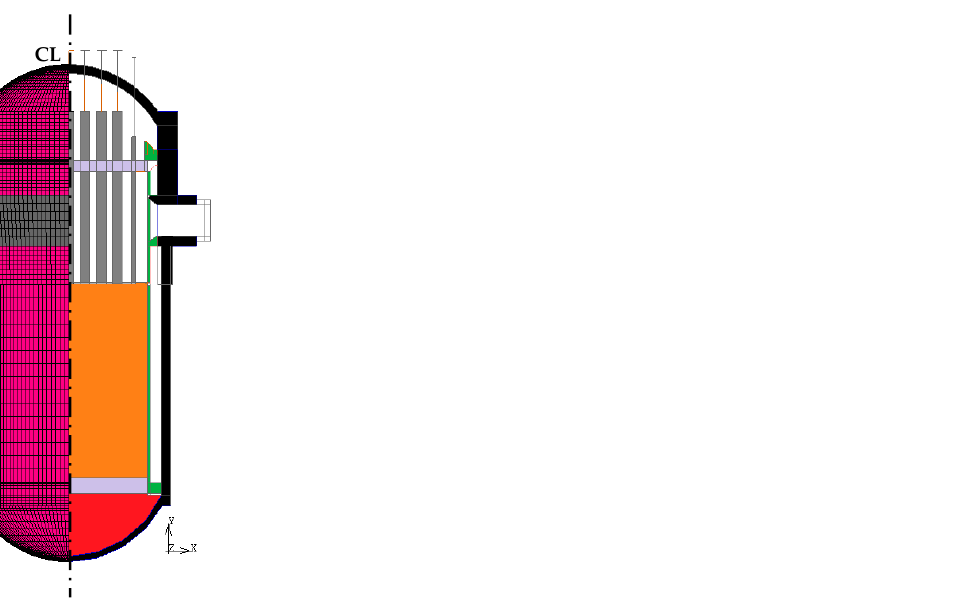
Figure 6. Vertical cross-section of the RPV model. On the right of the centreline (CL), the main internals are visible: the core region is shown in light orange; the red-coloured region is the lower head (facing the heating-up); the shroud and the control rod system are light green and grey-coloured, respectively. On the left of the CL, the 3D FE discretized model of the RPV is shown. The RPV’s lower head is loaded by the weight of the molten pool and the vessel, the internal pressure, and the temperature. The primary stresses are the internal pressure and dead weight (gravity), which are not relieved by the deformation of the vessel wall. How- ever, they increased due to the reduction of wall thickness.